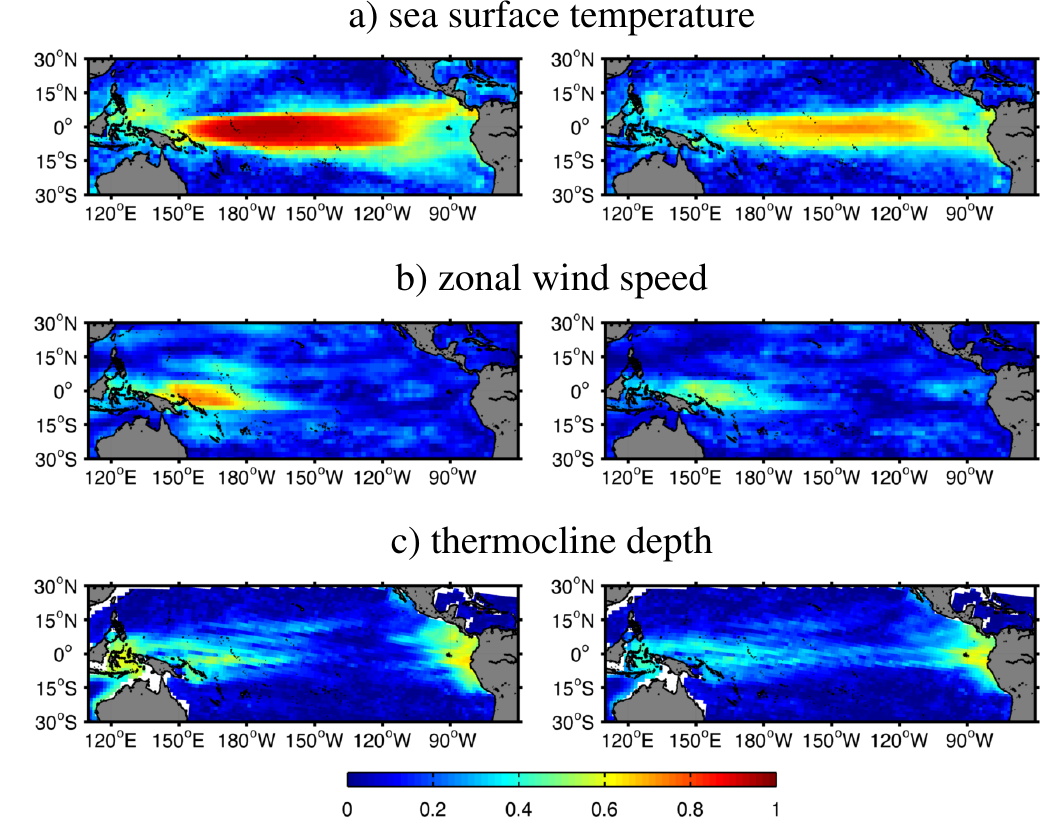
Fig. 5. Composite over 20 CT El Ni˜no events of the predictive power, PP(NINO4), gained by assimilating observations in MAM(0) for a given location (left panels); and the composite predictive power remaining in August (right panels). Assimilated quantities are (a) the SST, (b) the zonal wind speed and (c) the thermocline depth.